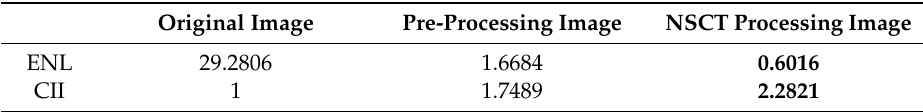
Table 2. Comparative analysis.